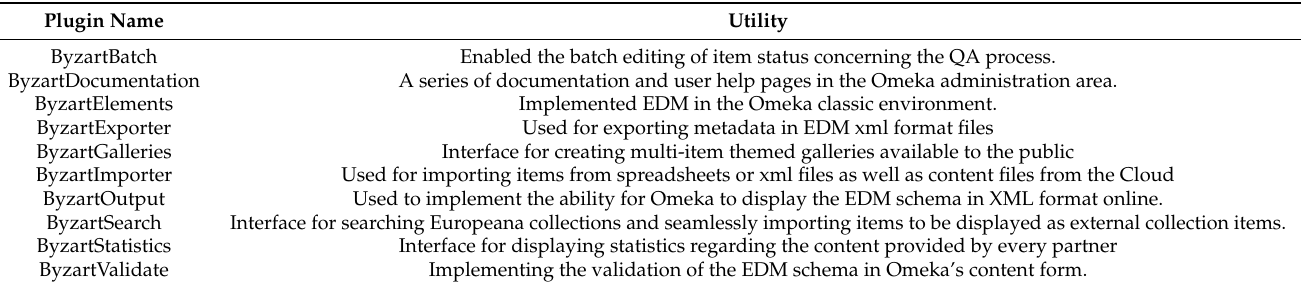
Table 1. Omeka classic plugins implemented for use in the BYZART project. Plugin Name Utility